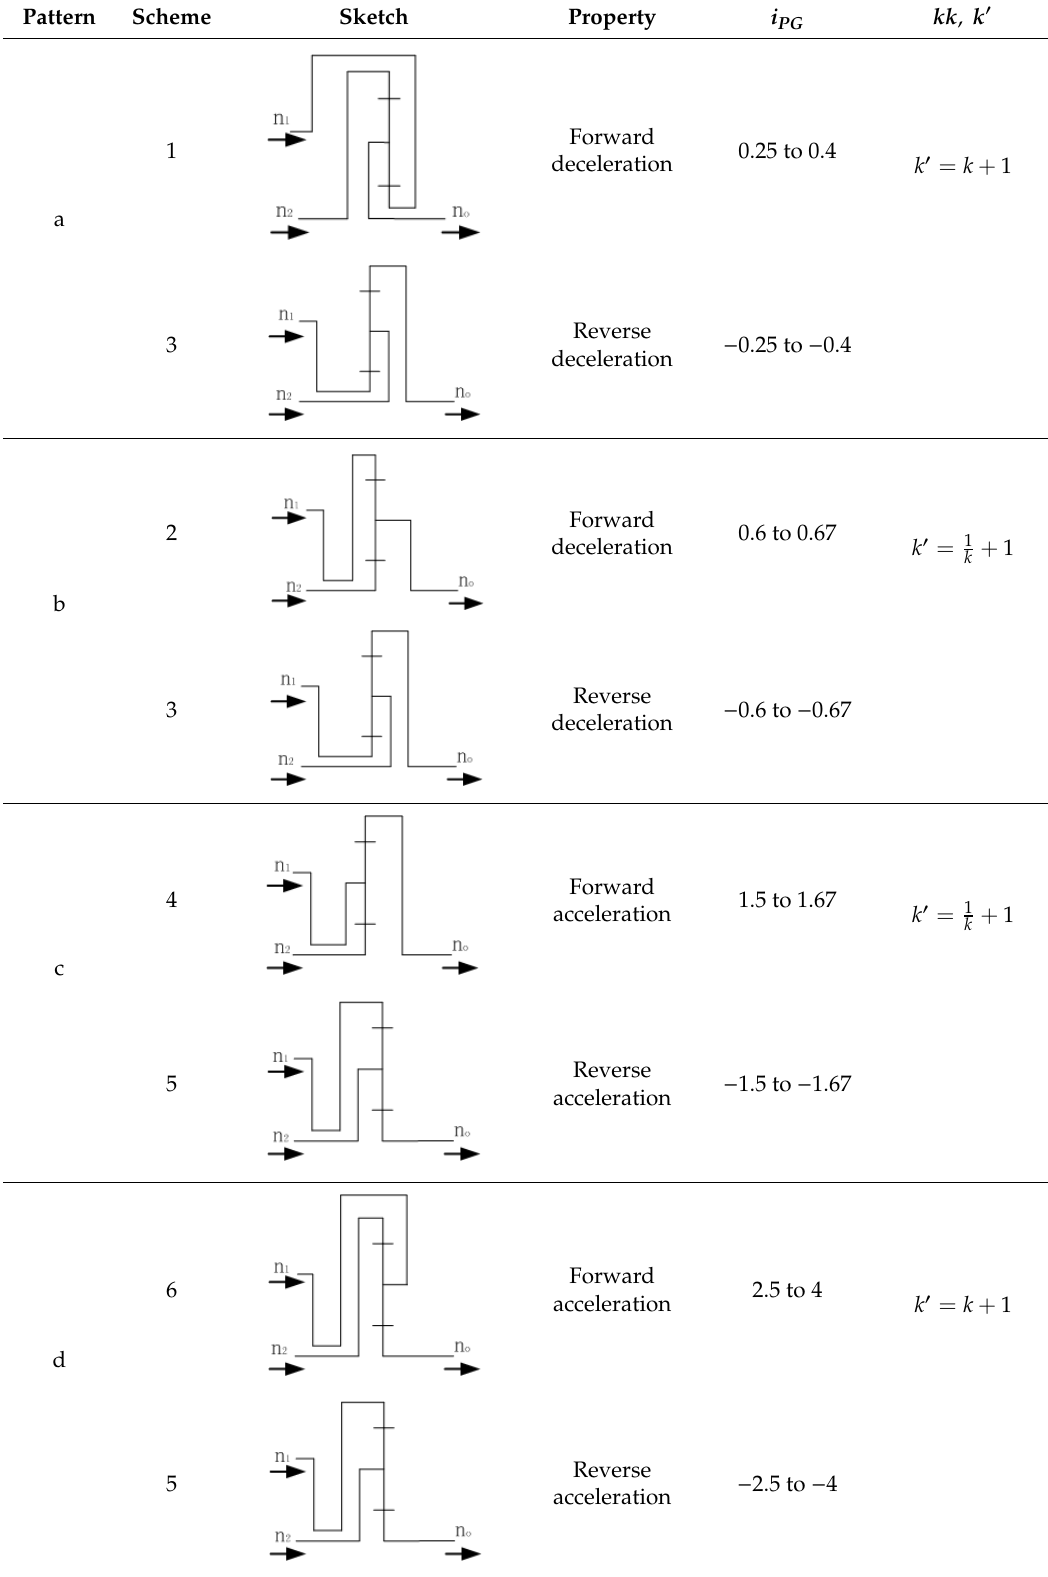
Table 2. The PG matching patterns of Table 2. The PG matching patterns of HMCVT. Table 2. The PG matching patterns of HMCVT. Table 2. The PG matching patterns of HMCVT. Table 2. The PG matching patterns of HMCVT. Table 2. The PG matching patterns of HMCVT. Table 2. The PG matching patterns of HMCVT. Table 2. The PG matching patterns of HMCVT. Table 2. The PG matching patterns of HMCVT.